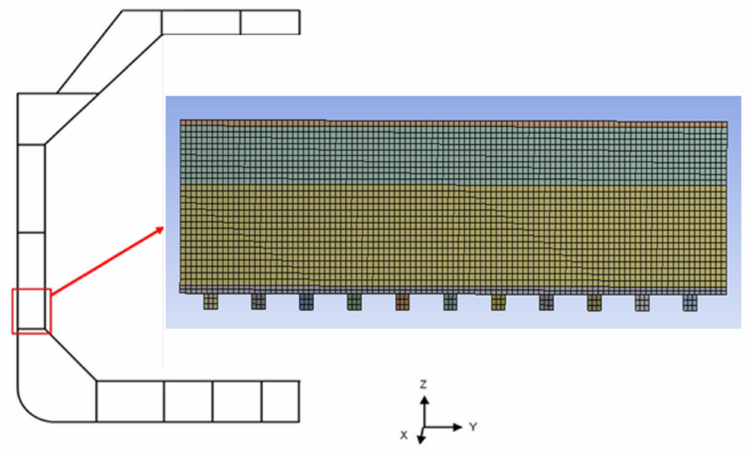
Figure 12. FE model of a Mark III insulation